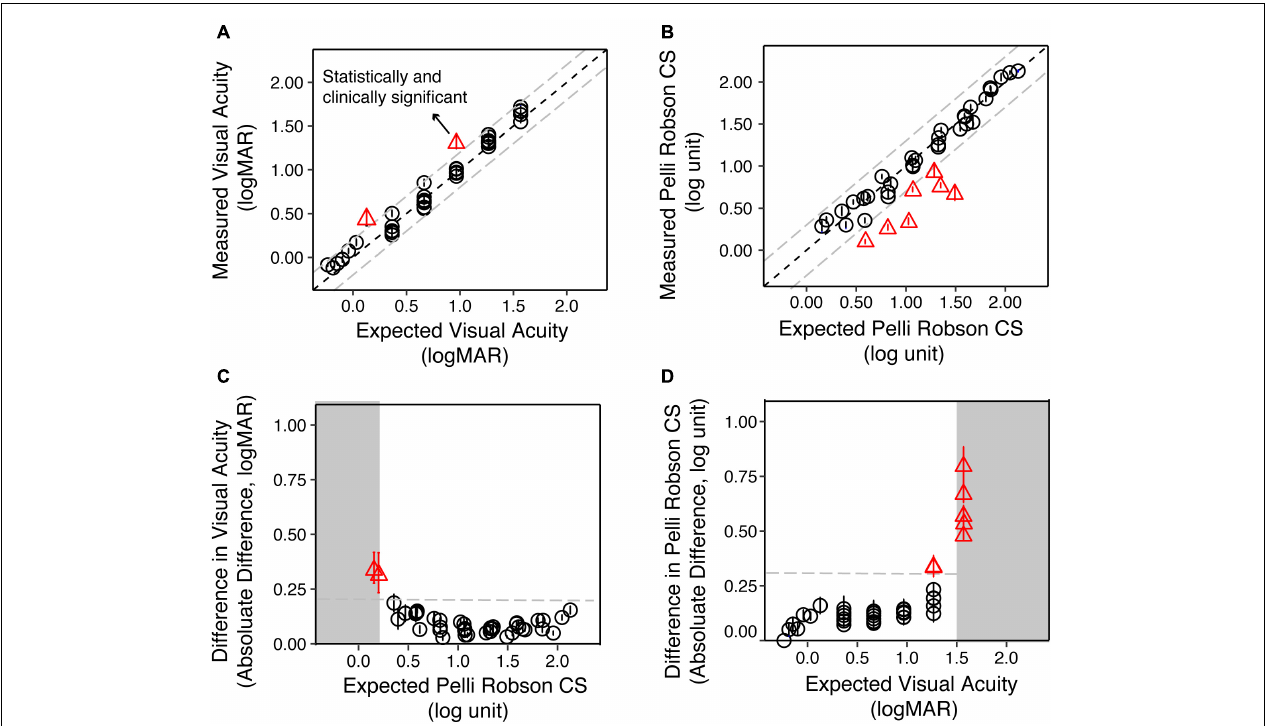
FIGURE 3 | The validity of simulating reduced contrast sensitivity and visual acuity in the Young Normal (YN) group. (A) The measured VA as a function of the expected VA. The circles represent the group average of each condition, and the error bars represent the standard errors. The red triangles represent conditions where the differences between the measured and expected values were statistically ( p < 0.05) and clinically significant ( > 0.20 logMAR). (B) The measured CS as a function of the expected CS. The red triangles represented conditions where the differences between the measured and expected values were statistically ( p < 0.05) and clinically significant ( > 0.30 log unit). (C) The difference between measured and expected VA as a function of the expected CS. When the expected CS was close to or worse than 0.15 log unit, the difference between measured and expected VA was the largest. (D) The difference between measured and expected CS value as a function of the expected VA. When the expected VA values were close to or exceeded 1.50 logMAR, the difference between measured and expected CS were the largest. In all four plots, the gray dashed lines represent the clinically significant difference in low vision (0.20 logMAR for VA and 0.30 log unit for CS),